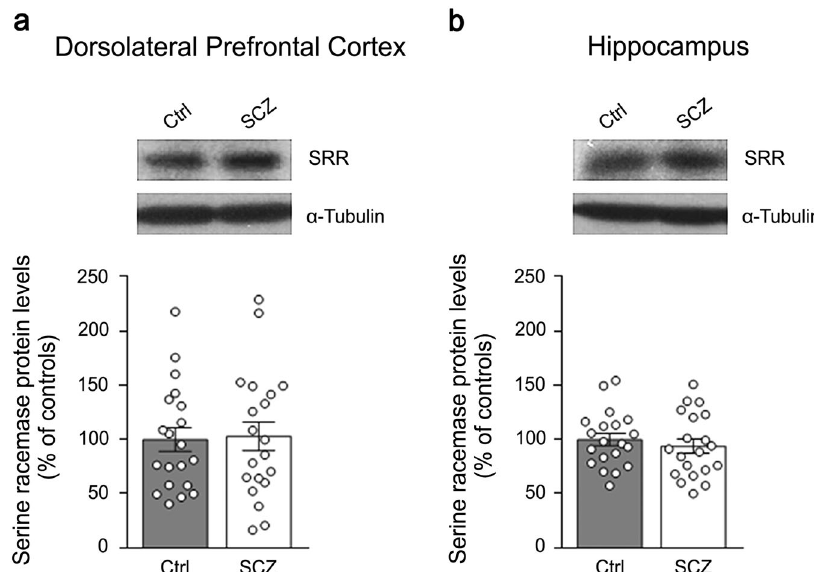
Fig. 5 Serine racemase protein levels in the post-mortem dorsolateral prefrontal cortex and hippocampus of patients with schizophrenia. The expression of serine racemase (SRR) was assessed by western blotting in the a dorsolateral prefrontal cortex and b hippocampus of schizophrenia-affected patients ( SCZ ) and control (Ctrl) individuals ( n = 20 per brain region and diagnosis). The variations of SRR protein levels in patients are expressed as percentage (%) of the control group (healthy subjects). α -Tubulin protein was used to normalize for variations in loading and transfer. Representative blots comparing the two diagnostic groups are shown above the graphs. Dots represent the single subjects ’ values while bars illustrate the means ±